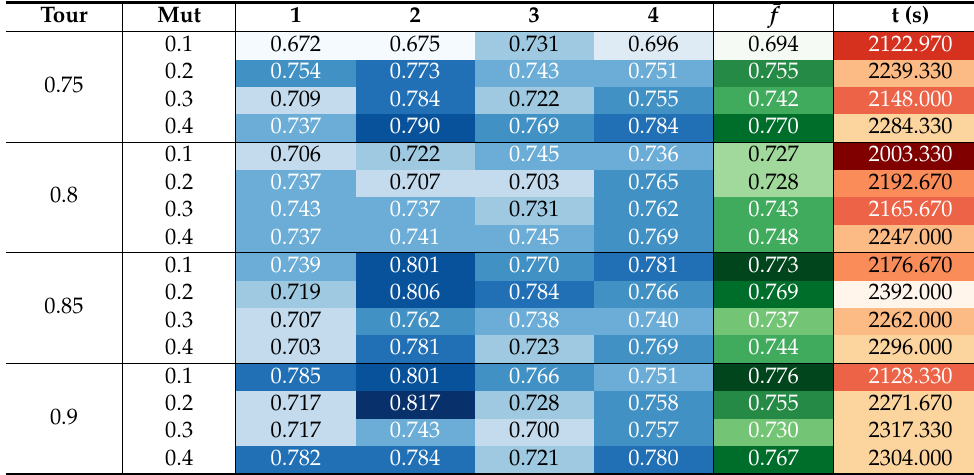
Table A2. Calibration results for map 533. Colored columns show fitness averages for each step (identified by step number), average over all steps ( ¯ f ), and runtimes (in seconds). Each row is a combination of two parameters: tournament probability (tour) and mutation rate